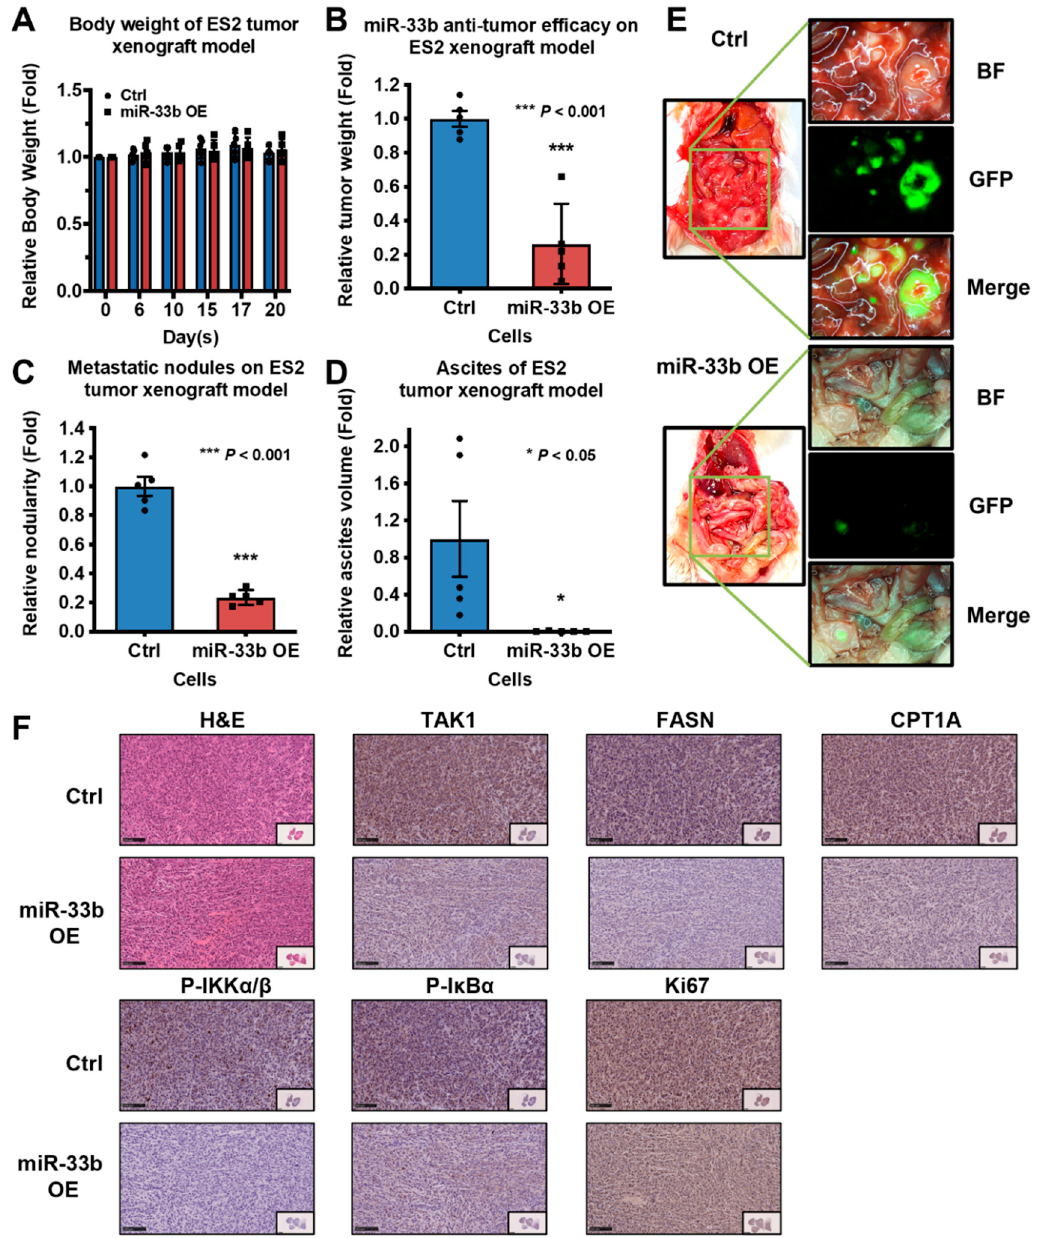
Figure 6. Overexpression of miR-33b inhibits tumor dissemination of metastatic ovarian cancer cells in vivo. ( A – D ) miR-33b overexpressing or scrambled control ES-2 cells with GFP label were intraperitoneally injected into 6–8 weeks old female SCID mice in a group of 5. The bodyweight of the mice was continuously monitored. The mice were sacrificed about 3 weeks later, and the body weight, tumor mass, number of tumor nodules, and ascites volume were measured. OE: overexpression. ( E ) GFP-labelled ES-2 cells were disseminated in the abdominal cavity, and tumor nodules were formed, which were visualized by fluorescence stereomicroscopy. BF: bright field. ( F ) The expression of TAK1, FASN, CPT1A, P-IKK α / β , P-I κ B α , Ki67 in tumor tissues of miR-33b overexpression and scrambled control groups were measured by IHC. scale bar: 100 μ m.